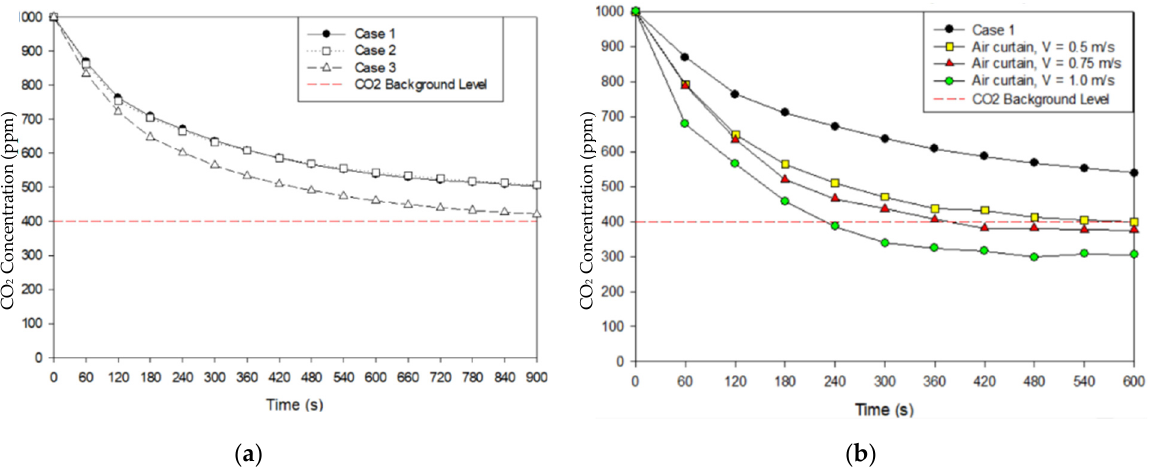
Figure 6. Concentration decay: ( a ) various cases based on locations of exhaust air; ( b ) case 1 with air-jet curtain.